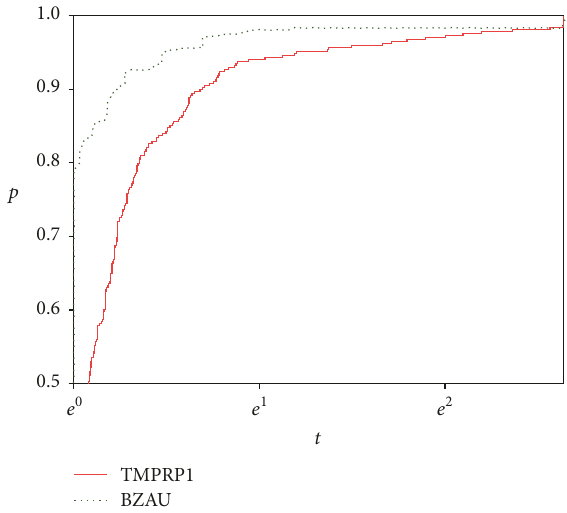
Figure 4: Performance profiles based on number of function